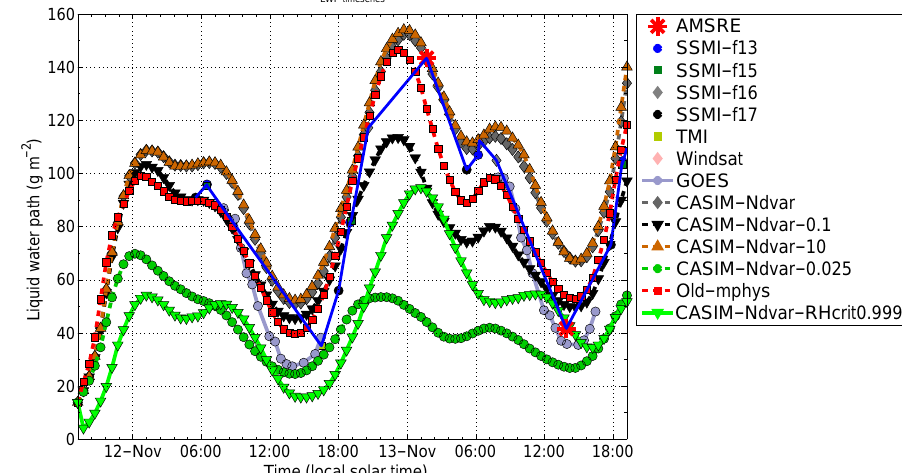
Figure 4. Time series of the mean LWP over the region of the UM domain for the different model simulations, the microwave satellite instruments, and the GOES-10 instrument. There are several microwave instruments that give snapshots throughout the diurnal cycle, as labelled in the legend; they are joined by the blue line. GOES-10 data are only used for the daytime, but they give higher time resolution. Retrievals where the solar zenith angle is larger than 65 ◦ have not been included due to likelihood of biases, as detailed in Grosvenor and Wood